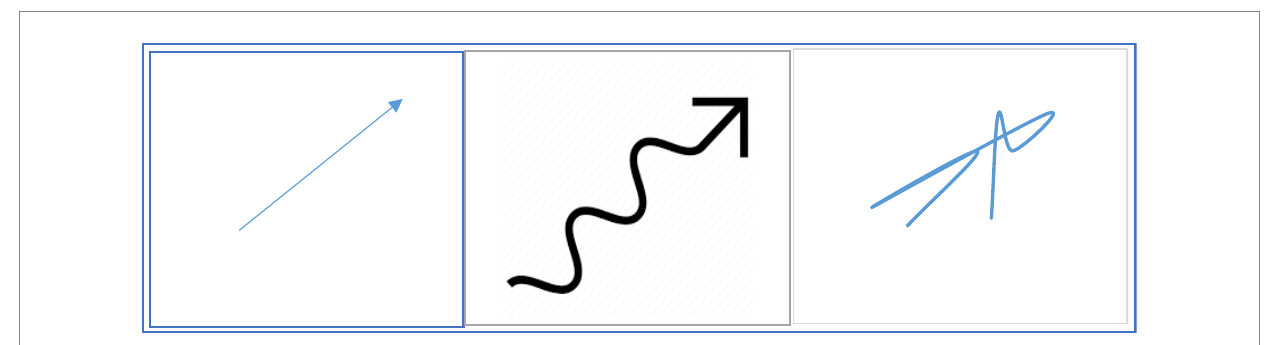
FIGURE 5 Different degrees of straightness and